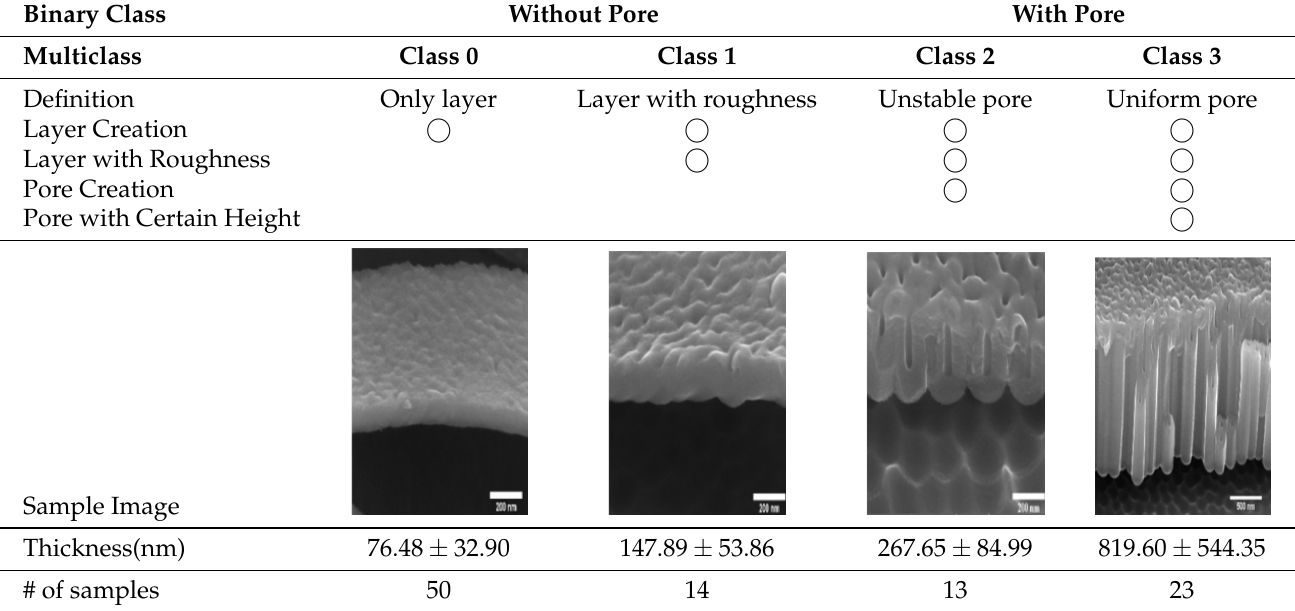
Table 1. Definition of four classes of pore structure and sample